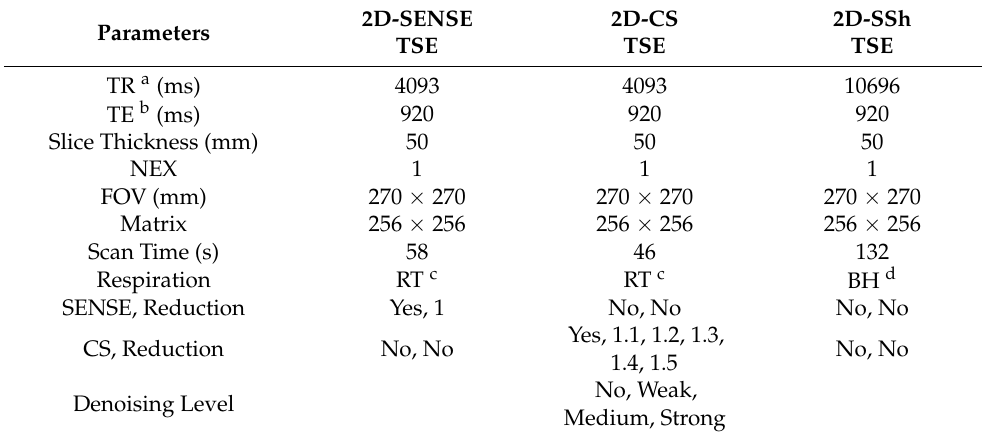
Table 1. Scanning Parameters for 3 pulse